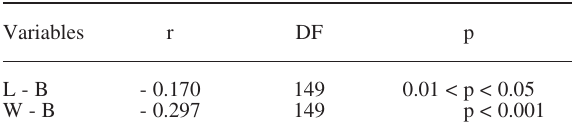
T ABLE 3. – Values of Pearson’s product-moment correlation coeffi- cient (r) between lorica length and number of bands (L - B) and lor- ica width and number of bands (W - B). DF = degrees of freedom, p = significance